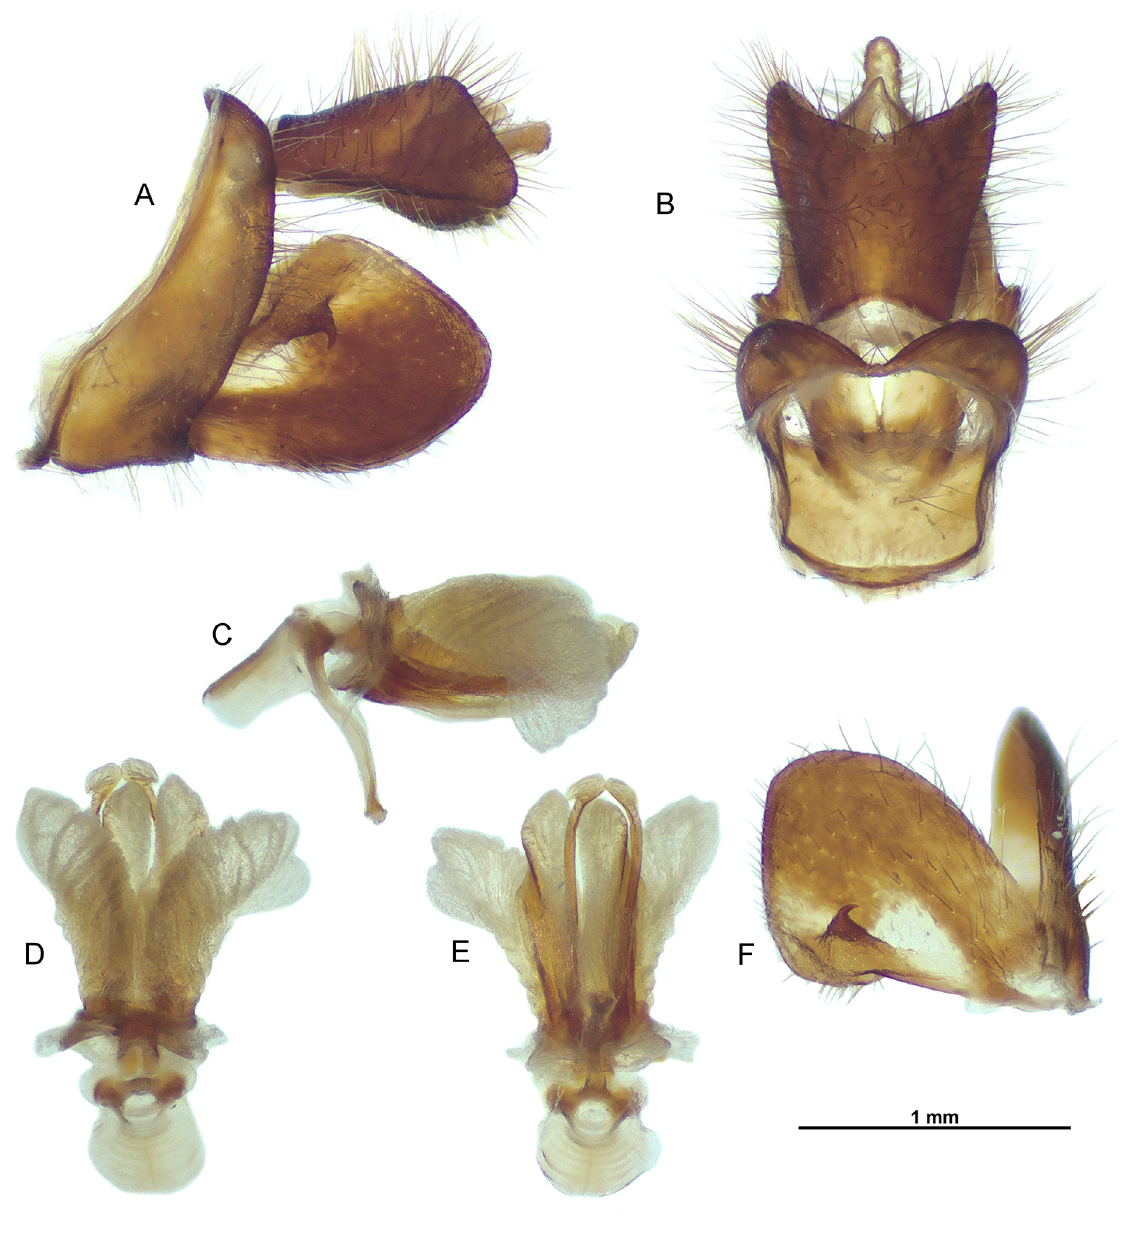
Fig. 12. Limois emelianovi Oshanin, 1908, Vladivostok, Anufriev leg., RBINS, male genitalia. A . Left lateral view (except phallic complex). B . Anal tube, dorsal view. C – E . Aedeagus. C . Left lateral view. D . Dorsal view. E . Ventral view. F . Gonostylus. Photographs by J.